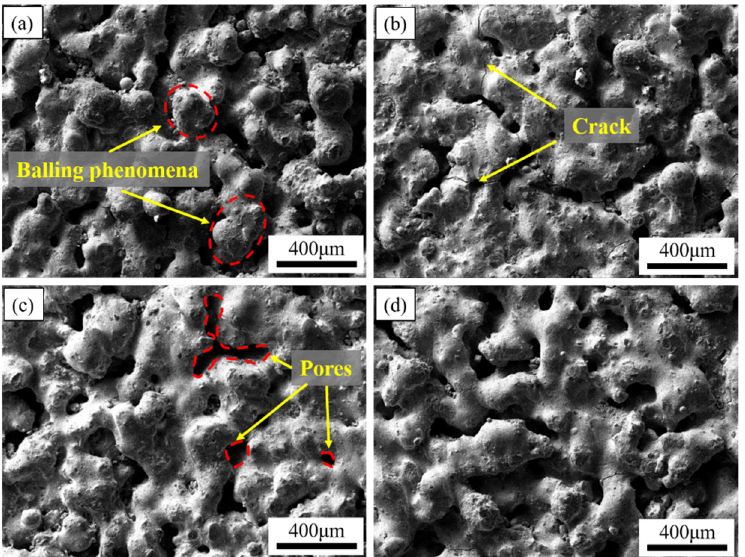
Figure 6. SEM images of the surface morphologies of the ISLF samples with different laser powers at a scanning speed of 150 mm/s: ( a ) 35 W, ( b ) 40 W, ( c ) 45 W, ( d ) 50 W.